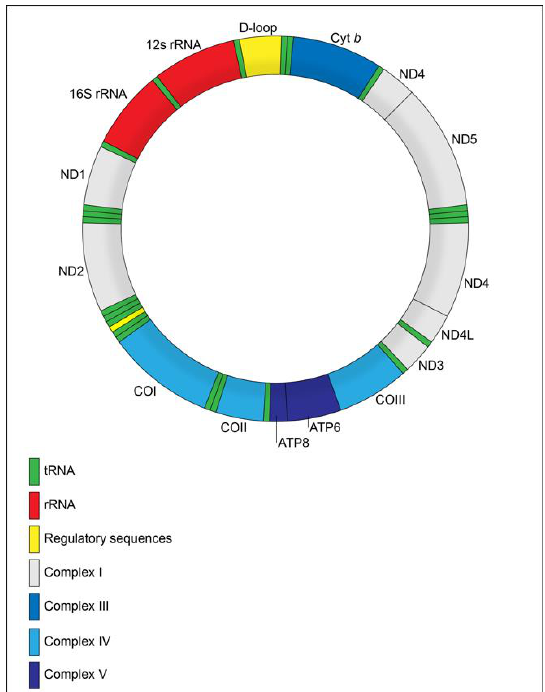
Figure 1. Mitochondrial genome. Map of the 16.6 kb, circular, double-stranded human mitochondrial DNA (mtDNA) molecule, showing the regulatory sequences (in yellow), 22 tRNAs (in green), two rRNAs (in red) and the 13 coding genes classified along the protein five complexes.